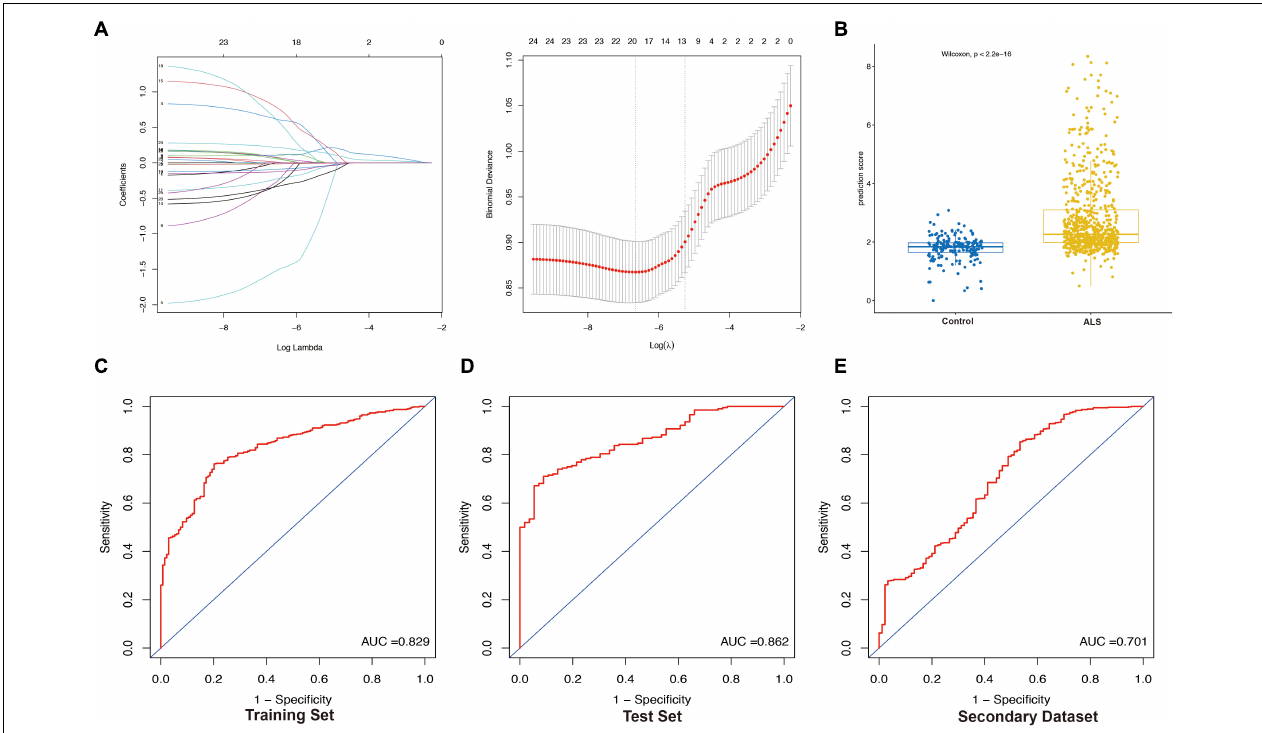
FIGURE 6 | Construction and validation of LASSO model. (A) Construction of LASSO model. (B) Boxplot was used to visualize the predictive performance of model. Each dot represents the prediction score of each person based on LASSO analysis. Receiver operating characteristic (ROC) curves analysis of predicting the occurrence of ALS. The area under the curve (AUC) was 0.829 in the training set ( N = 614) (C) ; 0.862 in the test set ( N = 260) (D) ; 0.701 in the secondary dataset ( N = 636) (E)